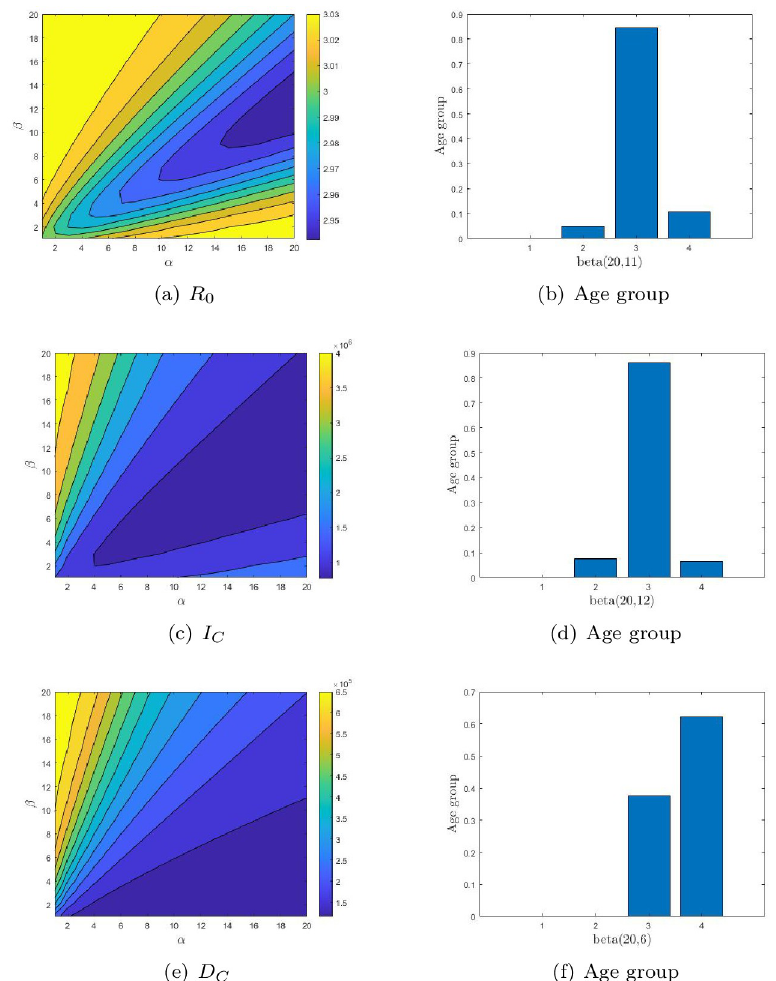
Fig 4. The contour plot of the three endpoints: The basic reproduction number ( R 0 , 1st row), the cumulative number of infections ( I , 2nd row) and the cumulative number of deaths ( D C age-specific vaccination distributions for these three endpoints are shown in (b), (d) and (f) respectively.